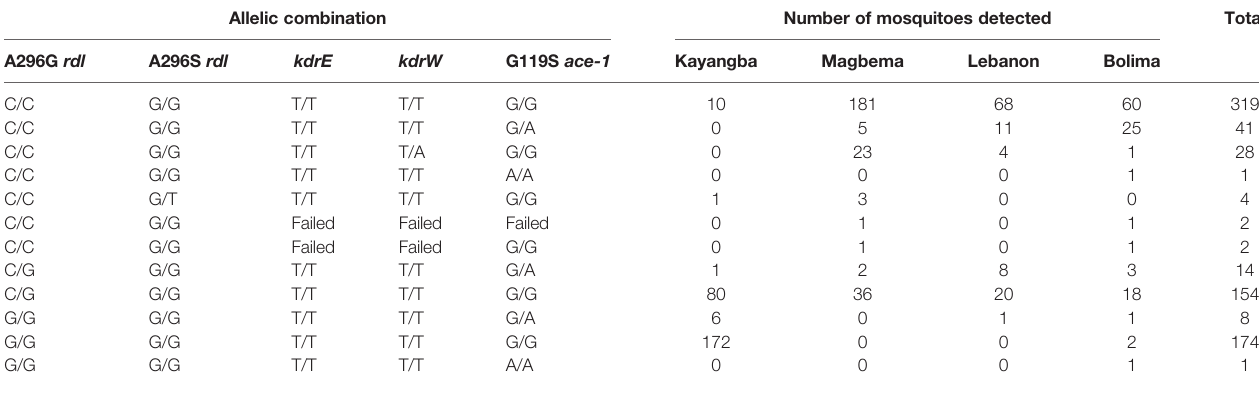
TABLE 5 | The mutations of the multiple insecticide resistance genes in An. gambiae from communities. Allelic combination Number of mosquitoes detected